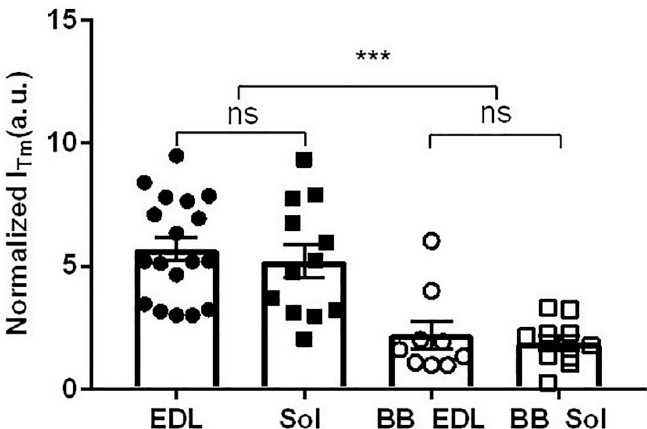
Figure 7. Normalized integrated intensities from Tm reflections from both normal contracting and fully blebbistatin inhibited muscle. EDL and Sol—untreated EDL, and soleus muscles respectively. BB_EDL and BB_Sol—maximally inhibited (<10% maximum force) EDL and soleus muscle, respectively. ***: p < 0.001.